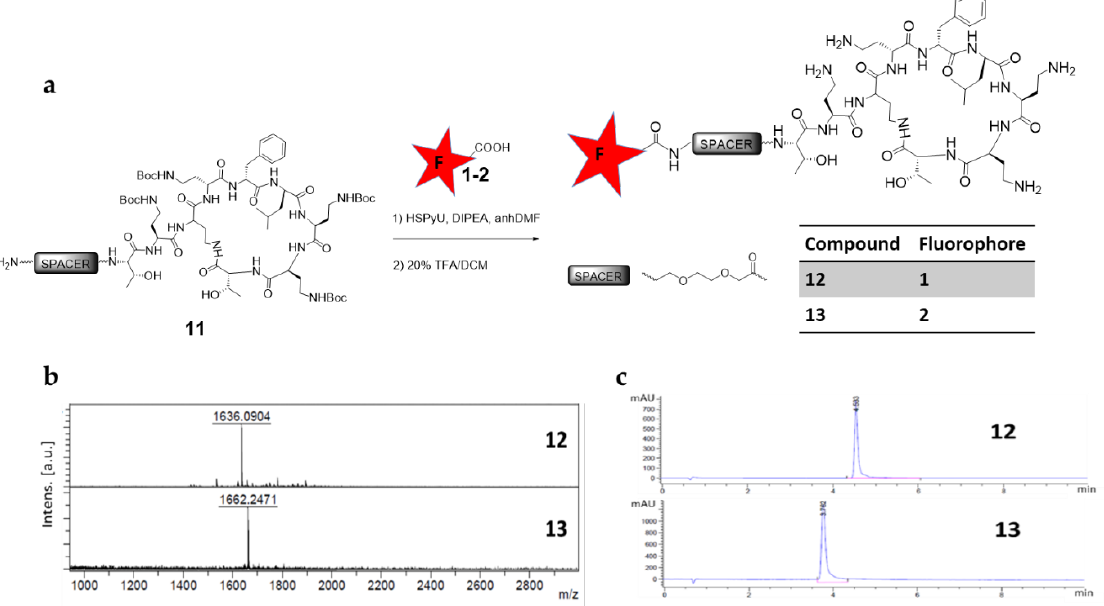
Figure 5. Synthesis and characterization of red-polymyxin probes. ( a ) Reaction of PMX scaffold 11 with fluorophores and deprotection to obtain meroBA-PMX ( 12 ) and meroSO-PMX ( 13 ). ( b ) MALDI-MS spectra of the compounds 12 and 13 . ( c ) HPLC chromatograms with detection at 550 nm ( 12 ) and 600 nm ( 13 ).